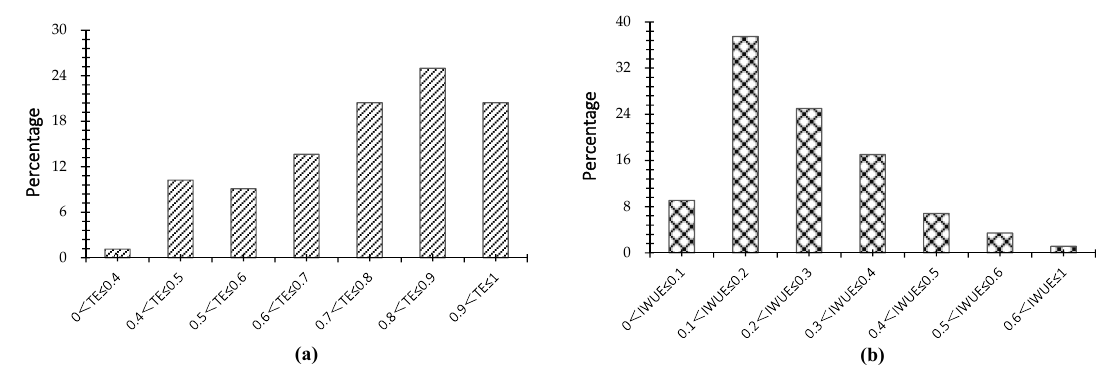
Figure 2. The frequency distribution of farm level efficiencies: ( a ) technical efficiency; and ( b ) irrigation water use efficiency of maize production in Zhangye City.